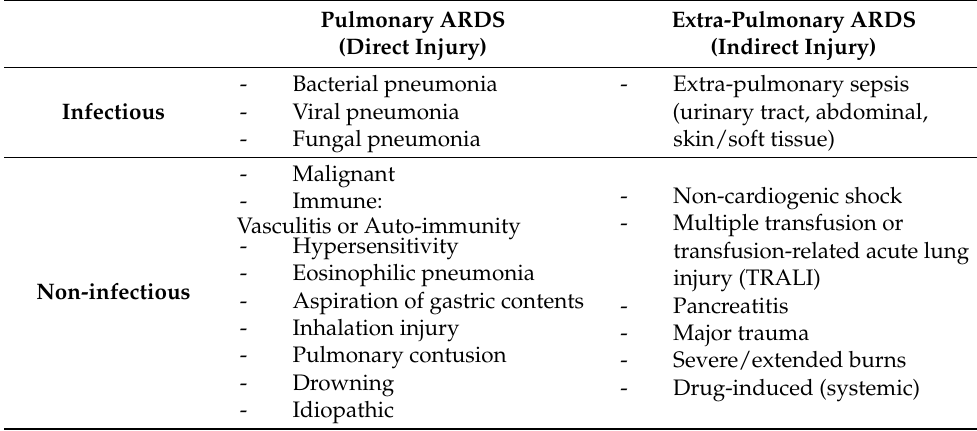
Table 1. Common risk factors triggering acute respiratory distress syndrome